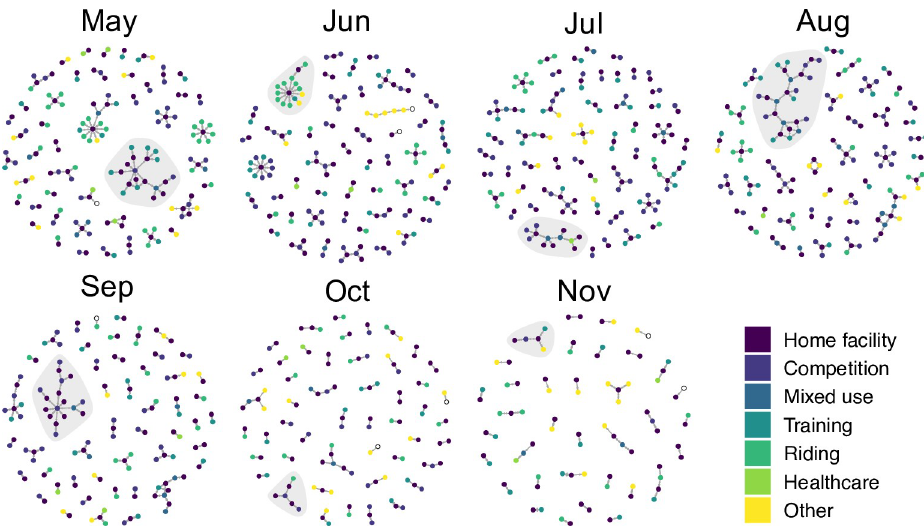
Fig 4. Monthly networks of horse movements between May and November 2015. Nodes represent locations and edges represent the directed movement(s) of at least one horse during the month. Node colour represents the type of location as determined by the reason for travelling there. The giant strong component (GSC) of each network is highlighted in